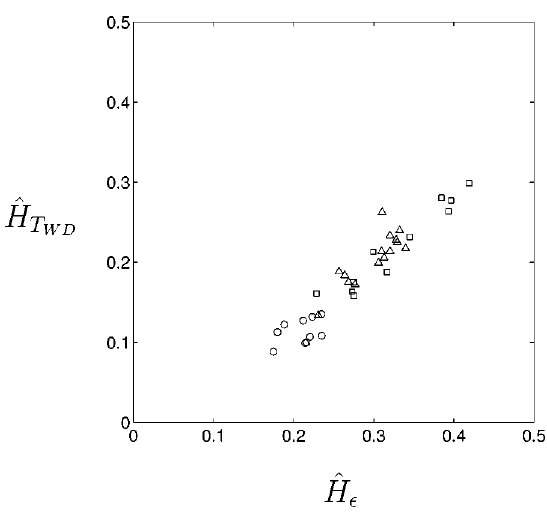
Fig. 8. Estimated Hurst parameters as obtained from the 1D poly- gonization method, ^ H T , are plottet versus estimates obtained WD from the 1D “ (cid:15) -blanket” method, ^ H (cid:15) , for samples from the nor- mal+regenerating ( (cid:14) ), noduli ( 4 ) and tumour ( 2 ) classes. The fea- ture values are extracted from the second 10% peripheral segment of the cell nuclei, and are given as average values of the estimates obtained from approximately 100 cells per